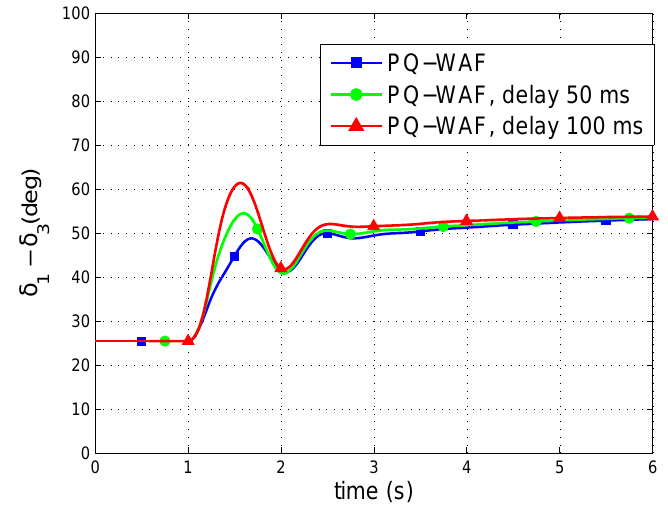
Figure 16. Q injections of the converters.